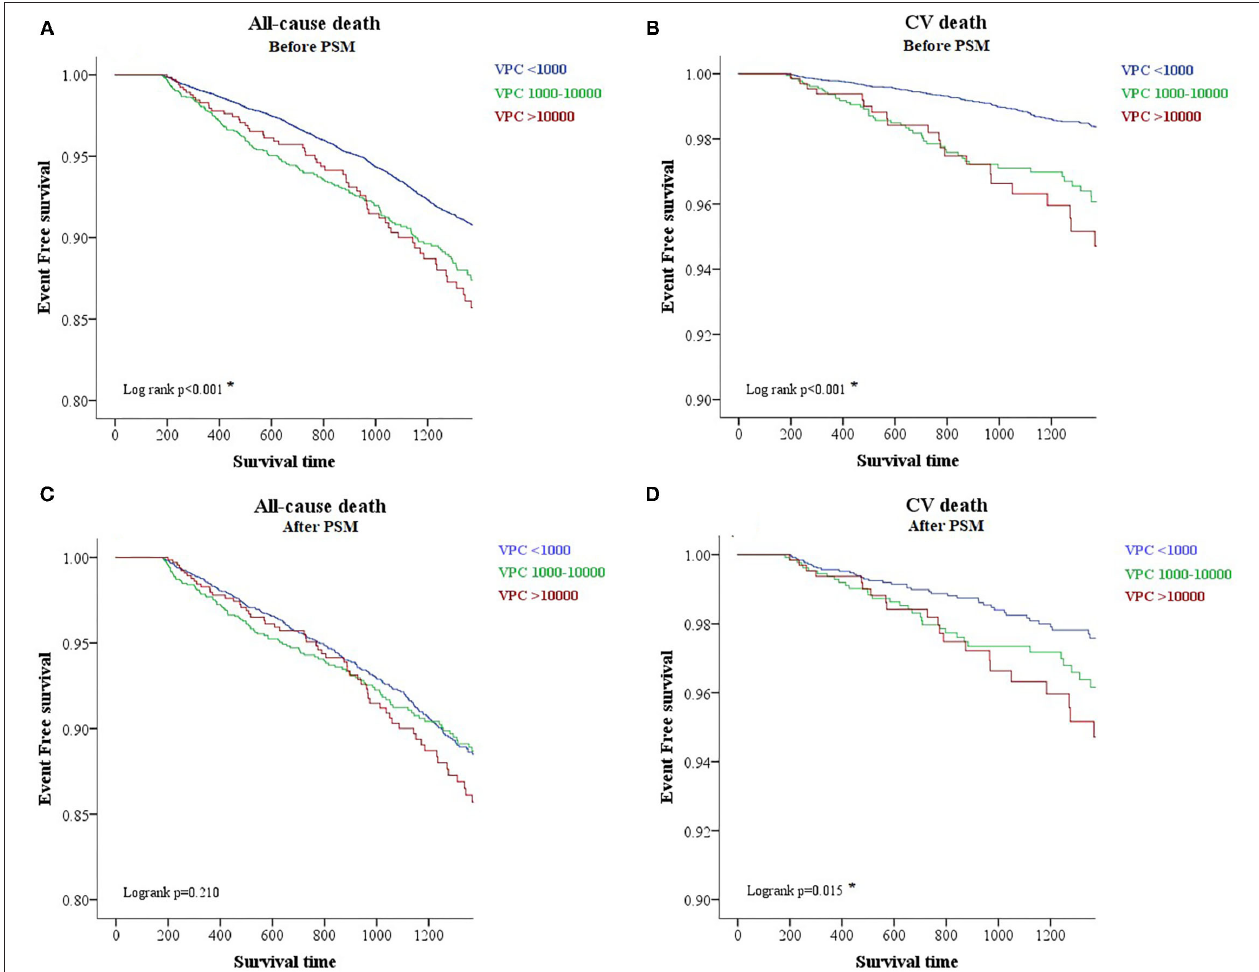
FIGURE 2 | A Kaplan-Meier survival plot of different burdens of VPC regarding all-cause and cardiovascular death before and after the propensity score matching analysis. A Kaplan-Meier survival plot before the propensity score match analysis shows that a higher burden of VPC is associated with more all-cause and cardiovascular death (A,B) . After the propensity score matching analysis, however, the effect of a higher burden VPC leads to more cardiovascular death but not all-cause death (C,D) . CV death, cardiovascular death; PSM, propensity score match